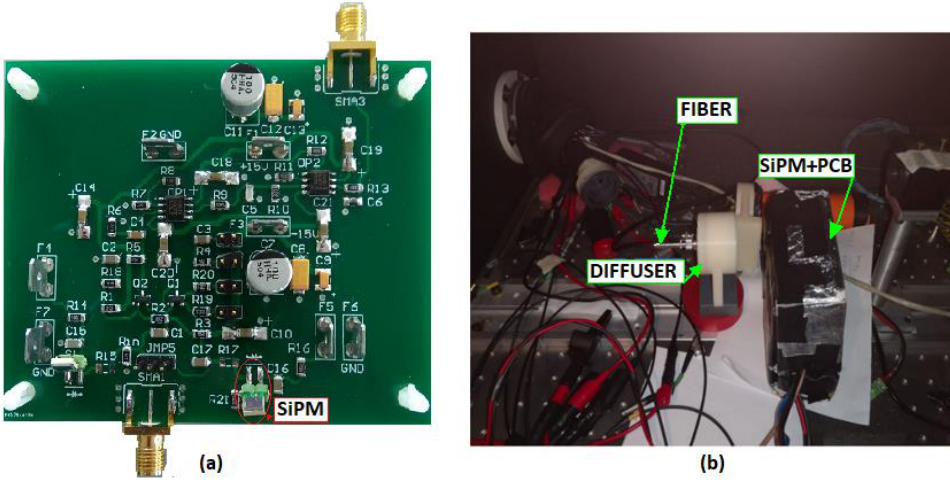
Figure 13. Pictures of ( a ) the printed circuit board used for the experiments and ( b ) the experimental setup in the dark box.